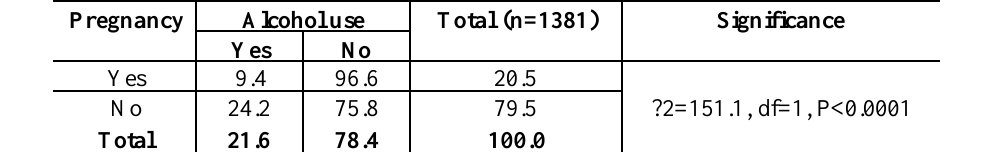
Table III : Alcohol used by married women in pregnancy; Dharan, 2002 (n=1381)